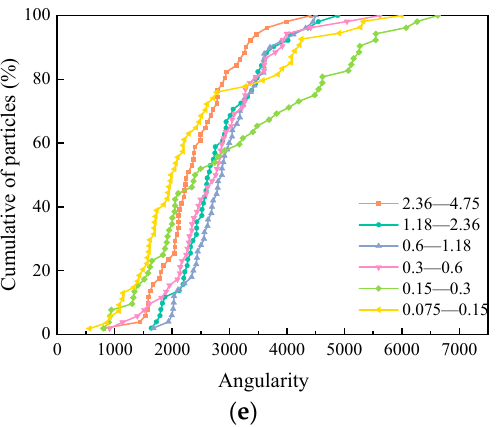
Figure 7. The angularities of five manufactured sands: ( a ) MSA, ( b ) MSB, ( c ) MSC, ( d ) MSD, ( e ) and MSE. The average values of the prism angle for different grain sizes of sand are shown in the radar diagram in Figure 8. With a decrease in particle size distribution, the angularity of the same kind of manufactured sand shows a trend of first increasing and then decreasing. The maximum angularity is obtained when the particle size range is 0.6–1.18 mm, while the minimum angularity is obtained when the particle size range is 0.075–0.15 mm. The maximum angularity values of MSA — MSE are 41.52%, 61.01%, 84.25%, 5.82%, and 21.18% higher than the minimum angularity values, respectively. This shows that MSC has the largest fluctuation of angularity, while MSD has the most stable fluctuation of angularity among the five kinds of manufactured sand. The angularities of the manufactured sands from different sources are also significantly different. From the perspective of the mean angularity of the whole particle size range, the angularity of MSC is the largest, followed by MSB, MSA, MSD, and MSE. In addition, the angularity within the range of 0.3–0.6 mm is the closest to the average value of the overall particle size, which can be used as a representative of the angularity of each manufactured sand.